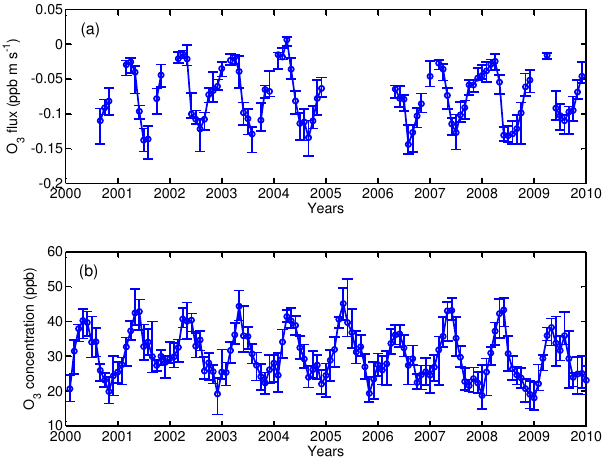
Fig. 1. Ten years time series of O 3 fluxes (a) and concentrations (b) . Monthly medians (circles) and quartiles of daily average fluxes and concentrations are presented.